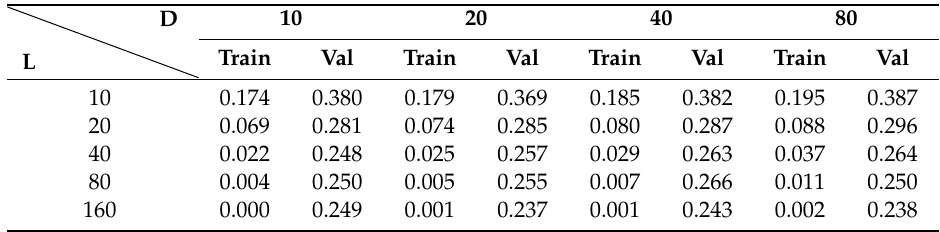
Figure 6. Parameter tuning results for ‘number of leaves’ and ‘minimum data in leaf’. Different lines represent different combinations of parameters (e.g., ‘L10_D20’ represents Number of leaves set to 10 and minimum data in leaf set to 20: ( a ) is the training data mean-square error (MSE) change with iteration step; and ( b ) is the test data MSE change with iteration step. Table 10. Mean square error (MSE) of number of leaves (L) and minimum data in leaf (D) pairs after 2000